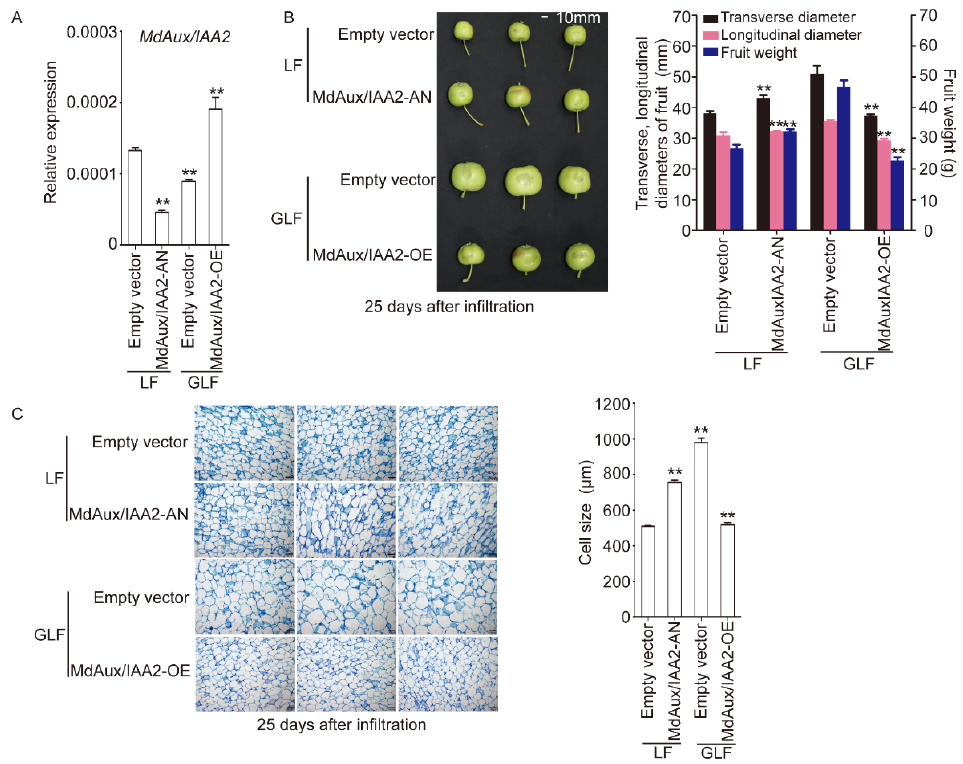
Figure 5. Functional identification of the MdAux/IAA2 gene. The expression of MdAux/IAA2 was measured in MdAux/IAA2-AN and MdAux/IAA2-OE fruit using qRT-PCR, MdActin gene (EB136338) was used as endogenous control; error bars indicate the standard deviation (SD) of three biological replicates ( A ). Fruit transversal diameter, longitudinal diameter, and weight were measured using a digital Vernier caliper and electronic scales 25 days after fruit injection; bar = 10 mm, error bars indicate the standard deviation (SD) of 10 biological replicates ( B ). Fruit cell and quantitative results in MdAux/IAA2-AN and MdAux/IAA2-OE apple fruit; error bars indicate the standard deviation (SD) of three biological replicates ( C ). Cell size was the average of six typical cell lengths, which were measured by a scale tool in the microscope 25 days after fruit injection; bar = 100 μ m. Empty vector, pRI101-overexpressing fruit. ** Significant differences ( p < 0.05, Student’s t -test).